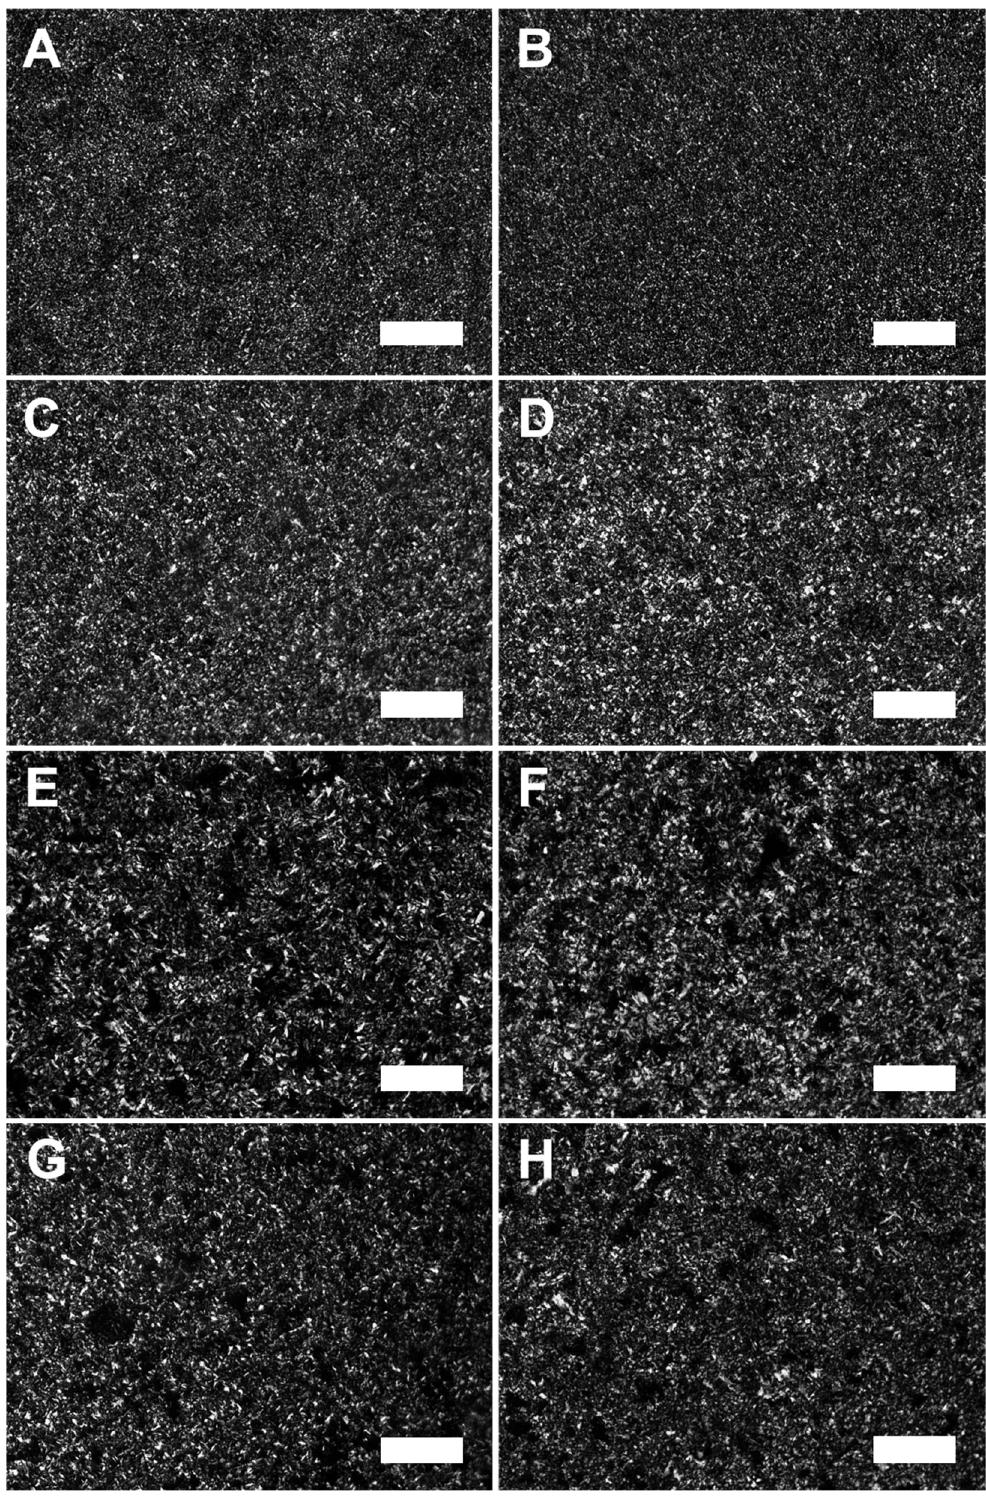
Figure 1. Representative PLM images for cocoa butter ( A – D ) and trilaurin ( E – H ) samples imaged at 10× magnification. ( A ) represents CB RS, ( B ) CB LS, ( C ) CB/M RS, ( D ) CB/M LS, ( E ) TL RS, ( F ) TL LS, ( G ) TL/M RS, and ( H ) TL/M LS. The white scale bar at the bottom right corner of each image represents 100 μ m in length.